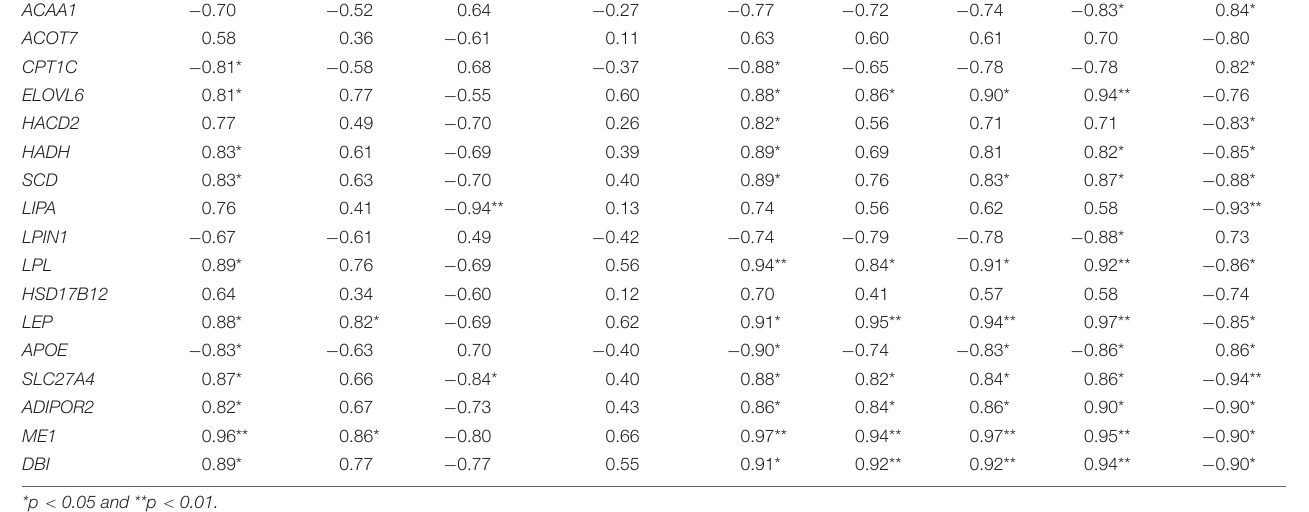
TABLE 5 | Pearson correlation of the important DEG expression involved in fat metabolism and the important DMs concentration. Variable